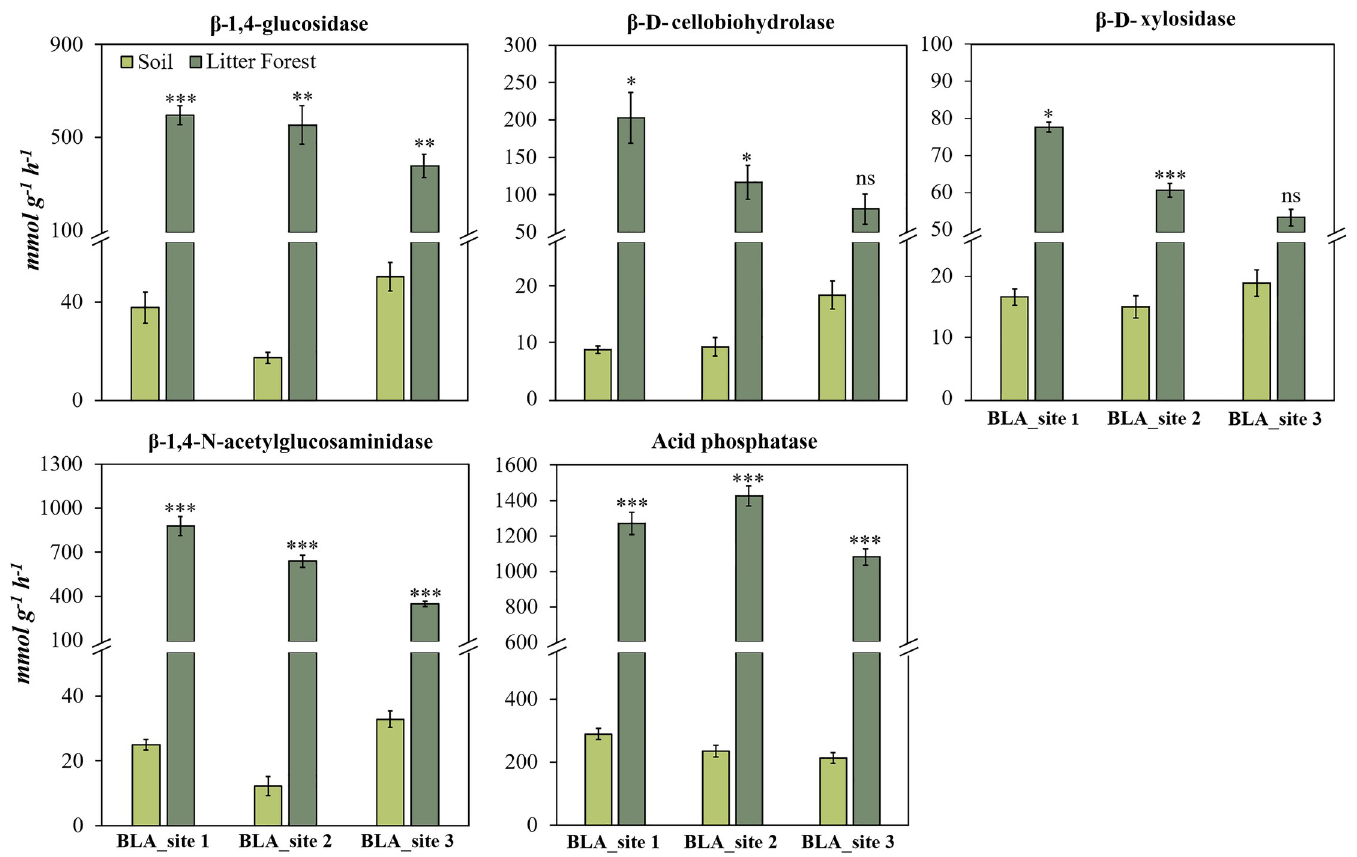
Fig 3. β -1,4-glucosidase, β -D-cellobiohydrolase, β -D-xylosidase, β -1,4-N-acetylglucosaminidase, acid phosphatase enzymes activities in soil and litter of forest mountain landscape sites over an Andes-Amazon transition in Colombian Amazon region. Error bars denote standard error. Asterisks indicate that the means values of soil and litter differ significantly between themselves to the level p < 0.05 ( � ), p < 0.01 ( �� ) and p < 0.001 ( ��� ) for each study site, according to the Student’s Test.